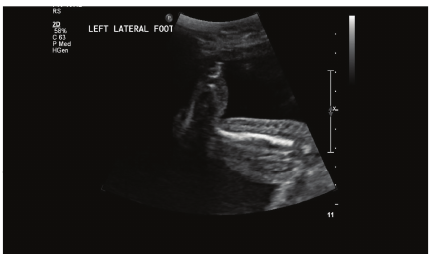
Figure 1: Note the swelling present along the dorsal aspect the left foot and throughout the distal left lower extremity. Figure 2: Note the swelling along the distal right lower extremity.